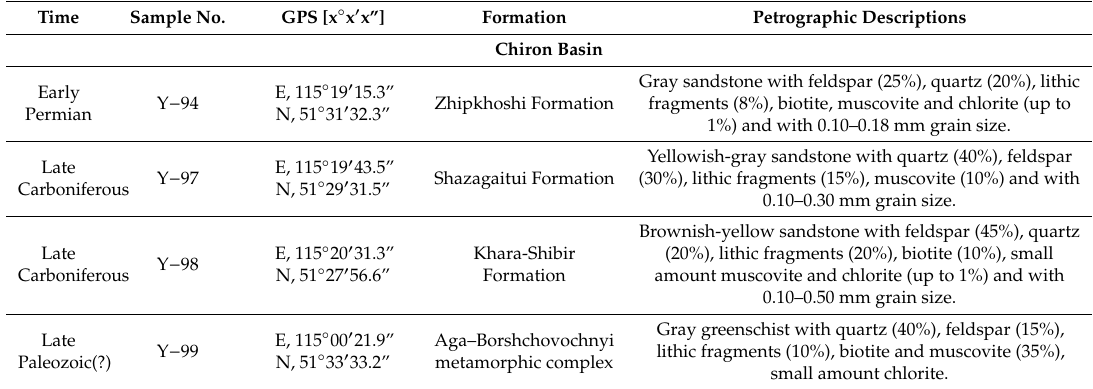
Table 1. Location and short description of